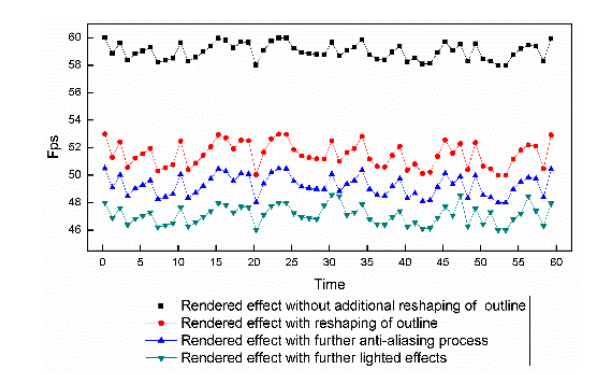
Figure 17. Comparison of the crossed-plane tree model (CPTM) (marked with red boxes) and the sphere-board-based tree model (SBTM) (marked with yellow boxes) for the particular tree species Sabina chinensis: ( a ) observed from a horizontal viewing angle, the SBTM presents a stereoscopic appearance, whereas the CPTM does not; ( b ) if the viewpoint is inclined gently toward the top side, the SBTM does not considerably change, whereas the CPTM gives a slight impression of slicing; ( c )